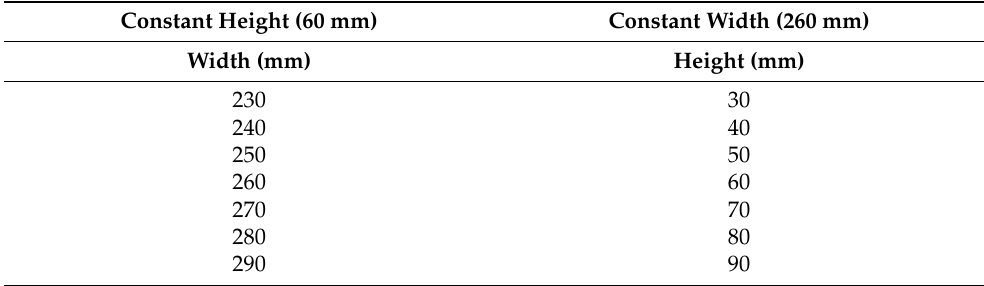
Table 8. Single loop rectangle dimensions with keeping either height or width